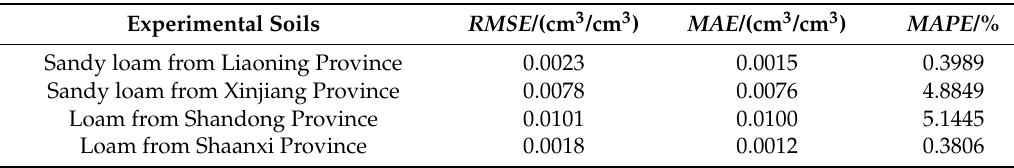
Figure 3. Measured and calculated soil water retention curves (SWRCs) for the experimental loam and sandy loam (the calculated SWRCs were obtained using the mean values of α and n from the three replicates). ( a ) The experimental soil is sandy loam collected from Liaoning Province; ( b ) The experimental soil is sandy loam collected from Xinjiang Province; ( c ) The experimental soil is loam collected from Shandong Province; ( d ) The experimental soil is loam collected from Shaanxi Province. Table 3. Error analysis for the measured and calculated soil moisture contents.